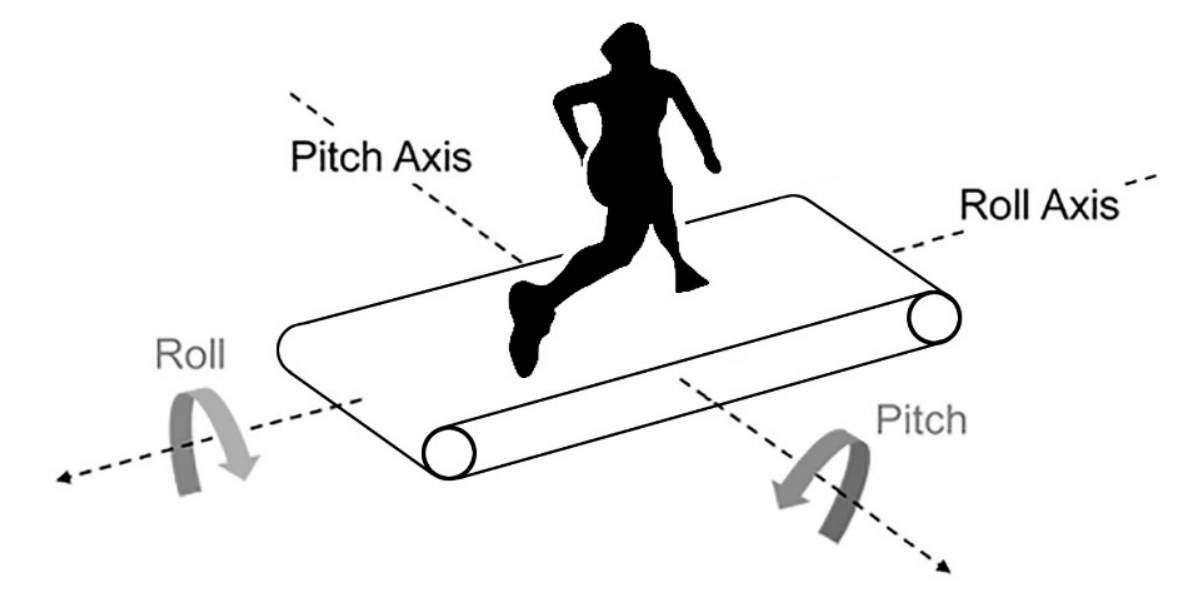
Figure 1. Inclinations allowed by the treadmill used in the study for URV and FC conditions.